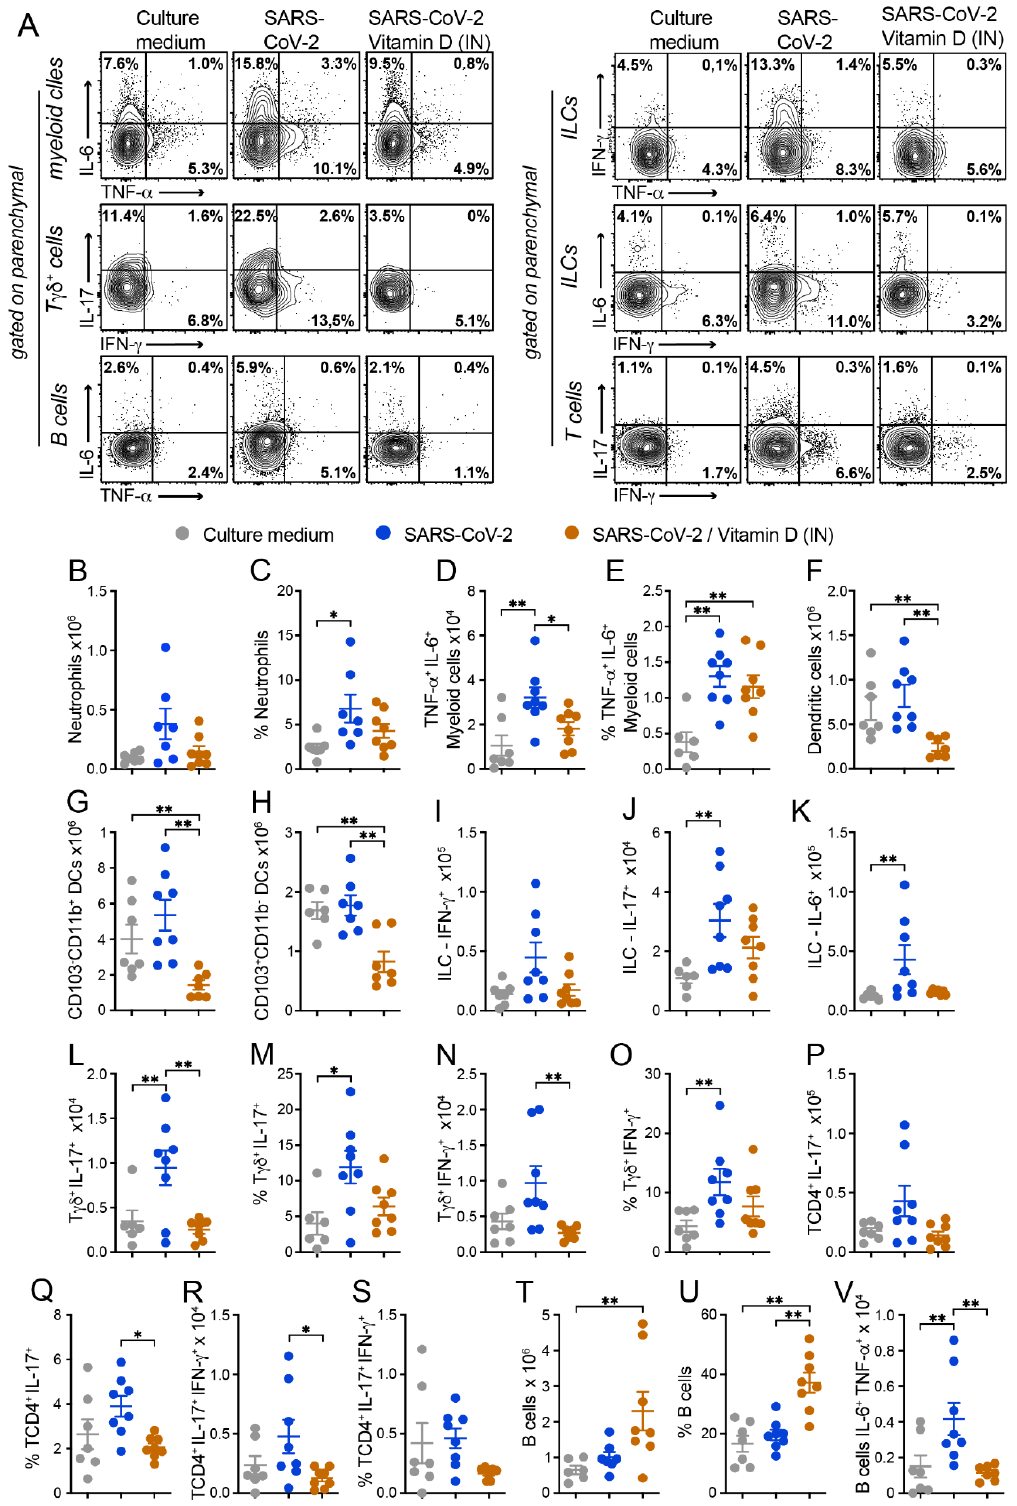
Figure 6. Effect of IN VitD on cell infiltration triggered by IN instillation of UV-inactivated SARS- CoV-2. C57BL/6 mice were instilled with the virus (3 doses of 4 × 10 5 PFU/each) on days 1, 3, and 5. Mice were treated with 3 VitD doses (0.1 µ g/dose) simultaneously with the SARS-CoV-2 inocu- lum. On the 7th day, the upper left lobe and the right lung were collected for flow cytometry analy- ses. In order to differentiate the parenchyma-infiltrating leukocytes from the vasculature-associated fraction, mice were intravenously injected with FITC-labeled anti-CD45 antibody 3 min before